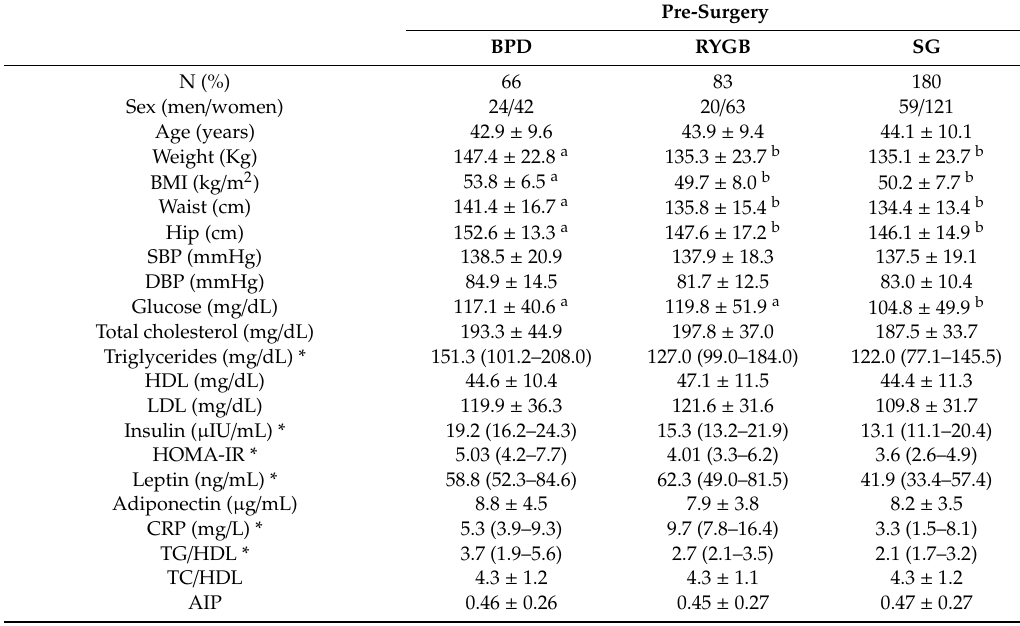
Table 1. Characteristics of patients with morbid obesity at baseline classified according to the type of bariatric